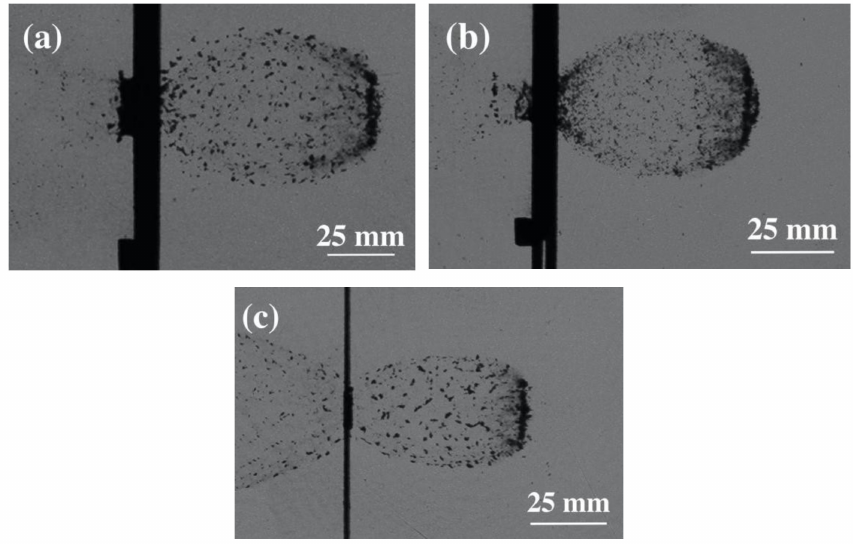
Figure 8. Late-time views of the debris clouds for di ff erent bumper. ( a ) bumper I; ( b ) bumper II; ( c ) aluminum alloy